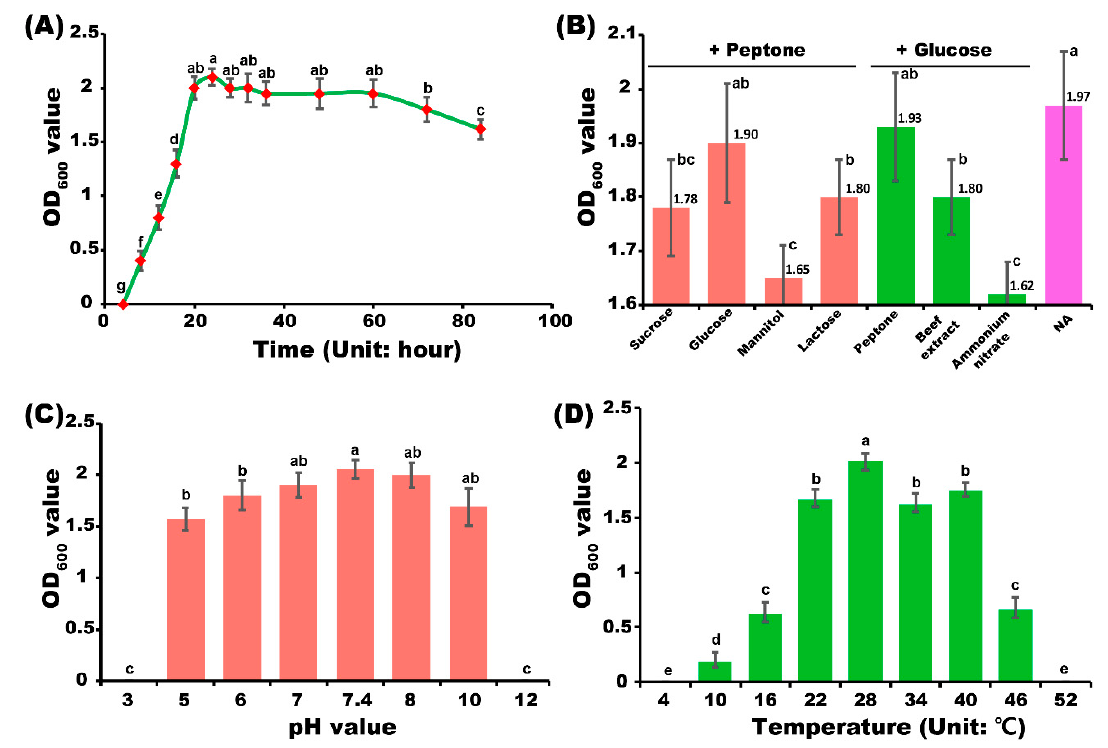
Figure 3. Optimization of fermentation conditions. ( A ) Growth curve of XS-2 grown in NA medium at different time points (28 °C , 180 rpm in dark). ( B ) Growth of XS-2 in liquid medium with different combinations of carbon and nitrogen sources. ( C ) Growth of XS-2 in NA medium at different adjusted pH values. ( D ) Growth of XS-2 in in NA medium under different temperatures. Each set of conditions received three replications from two independent experimental duplications. Values are means ± SD ( n = 6). Different letters above the bars indicate a significant difference at p < 0.05.